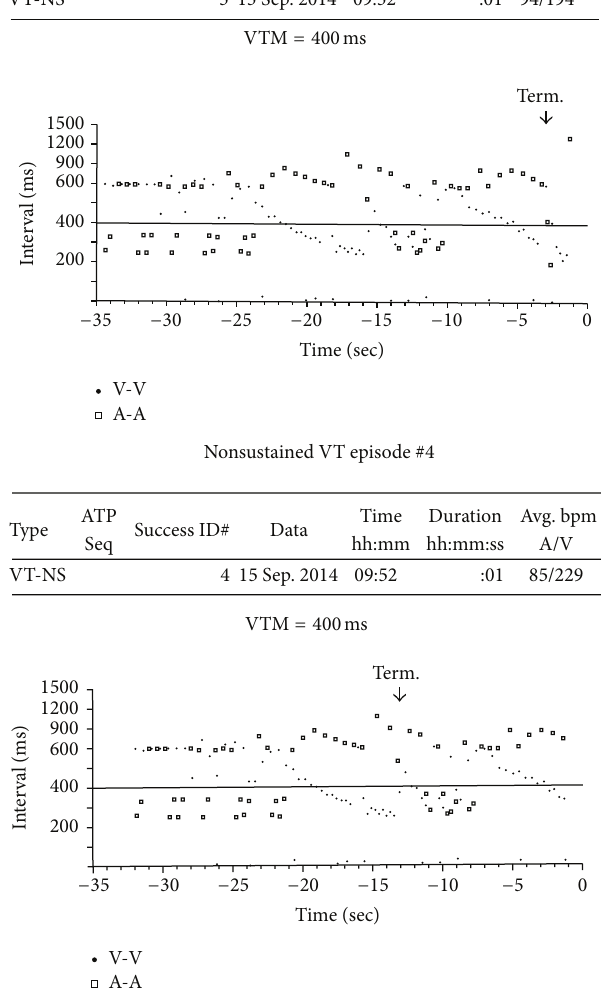
Figure 1: Cycle length plots from patient’s device showing ventric- ular tachycardia (more ventricular vents compared to atrial events) corresponding to patient’s syncope and